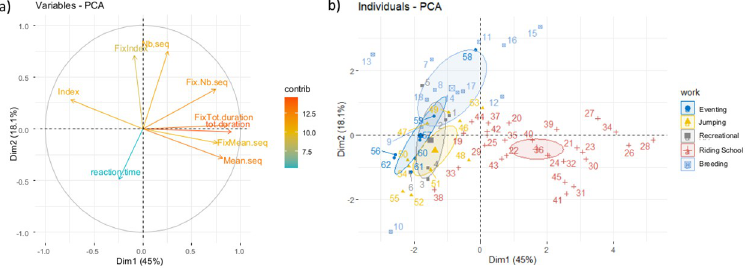
Fig 2. Graphical results from the Principal Component Analysis (PCA). a) Variables factor map obtained from the PCA on attention characteristics. A small angle between variables implies positive correlation, a large one suggests negative correlation, and a 90˚ angle indicates no correlation between two characteristics. Dimension 1 corresponds to the first component and opposed the total durations of both overall and fixed attention to the index of fragmentation. Dimension 2 corresponds to the second component and opposed the number of overall attention sequences and the index of fragmentation to the reaction time and mean duration of sequences of overall attention; Variables with high contribution to the dataset variance are in red/orange whereas variable with low contribution are in blue; b) Factor map obtained from the PCA illustrating the distribution of horses according to their attention characteristics (each number correspond to a horse). Colors and ellipses illustrated the type of work (Eventing: N = 7; Jumping: N = 10; Recreational: N = 6; Riding school: N = 27; Breeding: N = 12). Barycenter for each work type are